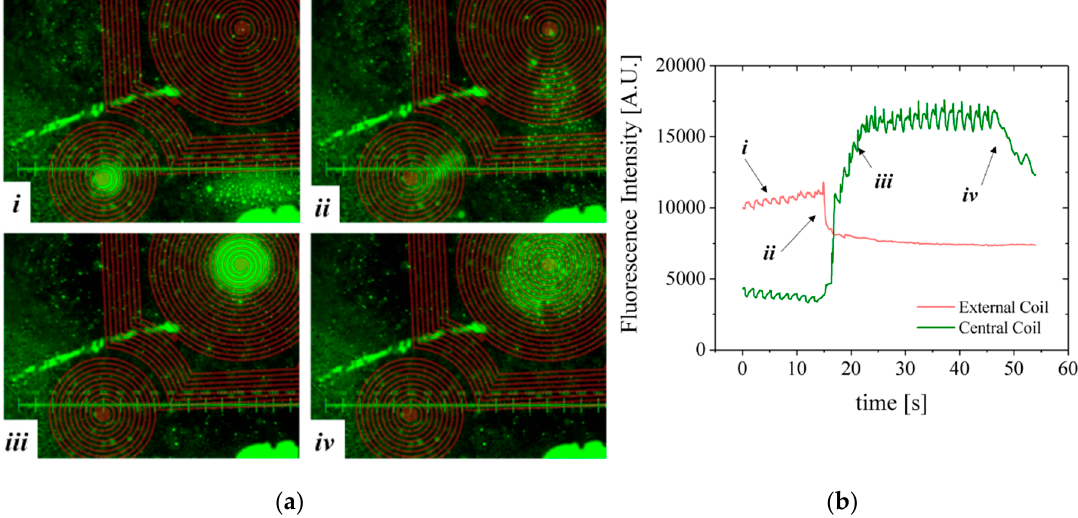
Figure 11. ( a ) Experimental results from CRIN MEMT 1 s activation / 0.5 s deactivation pulses and resulting MB concentration. The current is inverted after 9 pulses. (i) 9 pulses activation period of − 1 A; (ii) inversion of the current to + 1 A; (iii) increasing attraction of MB to the central coil; (iv) sequence stop. ( b ) MB fluorescence signal over time of actuation. Separation between the MEMT and the channel bottom: 100 µ m. (Video S3: multimedia view).